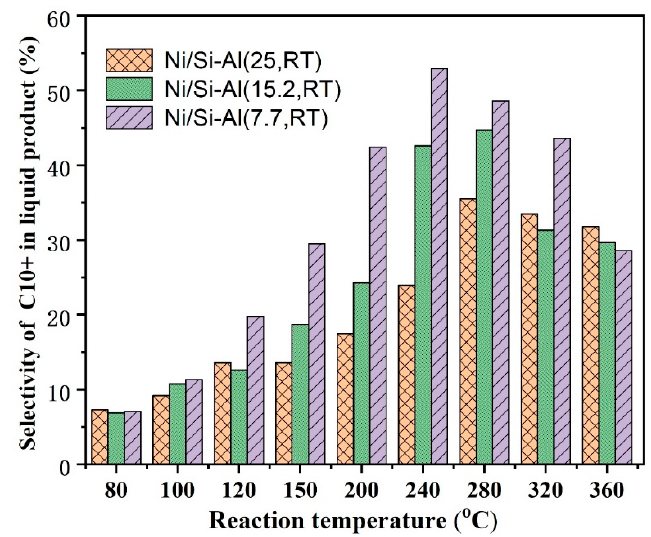
Figure 9. C 10 + product of ethylene oligomerization catalyzed by Ni / Si-Al (25, RT), Ni / Si-Al (15.2, RT) and Ni / Si-Al (7.7, RT). Reaction conditions: Pressure: 3.5 MPa; WHSV: 2.0 h − 1 ; Ni precursor: Ni(NO 3 ) 2 ; pretreatment temperature: 300 ° C.